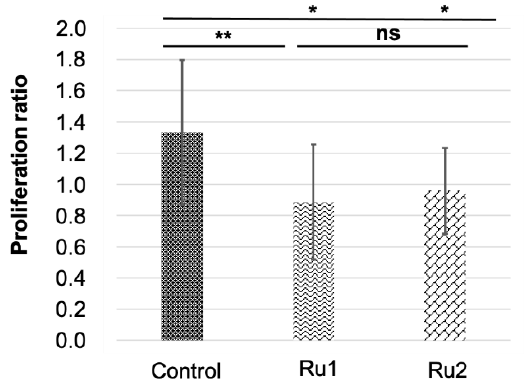
Figure 9. Comparison of MCF7 tumor cell variation in zebrafish embryos in control individuals and those exposed to antitumor drugs. * p < 0.05; ** p < 0.01; ns = not significant. Bars indicate standard deviation.